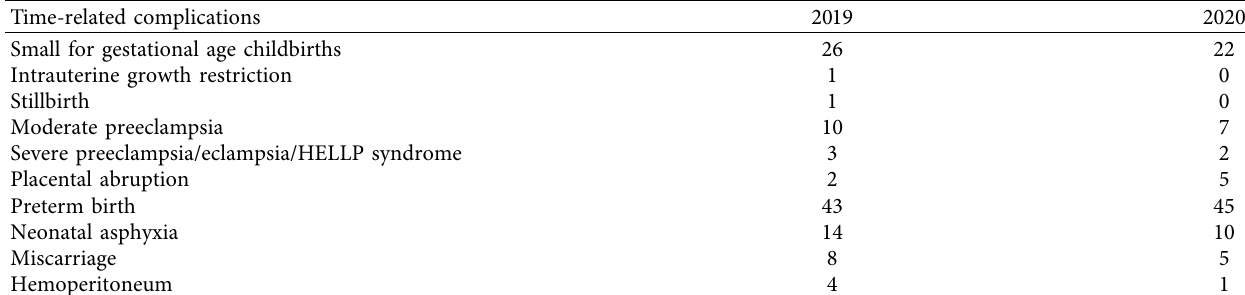
Table 8: Time-related obstetric and gynecological